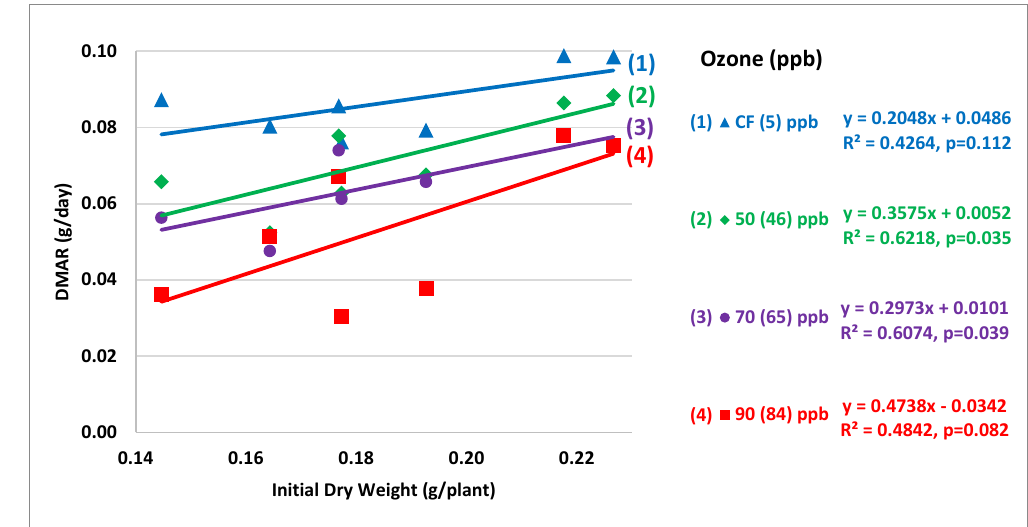
Figure 12. The regression line of the dry matter accumulation rate (per plant per day) on the initial weight of the seven bread wheat genotypes under different O 3 treatments (10, 50, 70, and 90 ppb) for 14 days (12 h/day). Actual treatments achieved were 5, 46, 65 and 84, respectively.